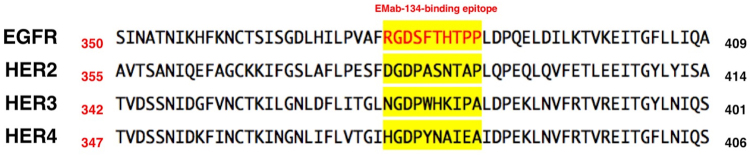
Comparison of acid sequence among HER families.